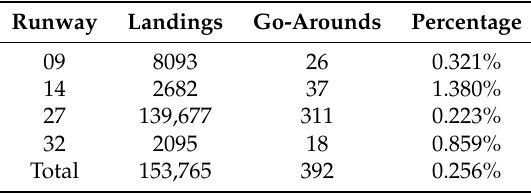
Table 1. Summary of runways, landings and go-arounds at Chhatrapati Shivaji Maharaj International Airport (VABB) during the study period, 1 August 2018 until 19th August